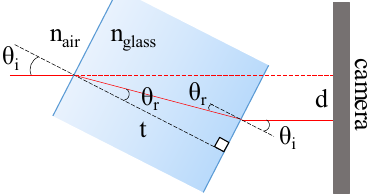
Fig. 1. Lateral displacement d , in a camera, of the beam with incident angle θ i , by a glass sample of thickness t